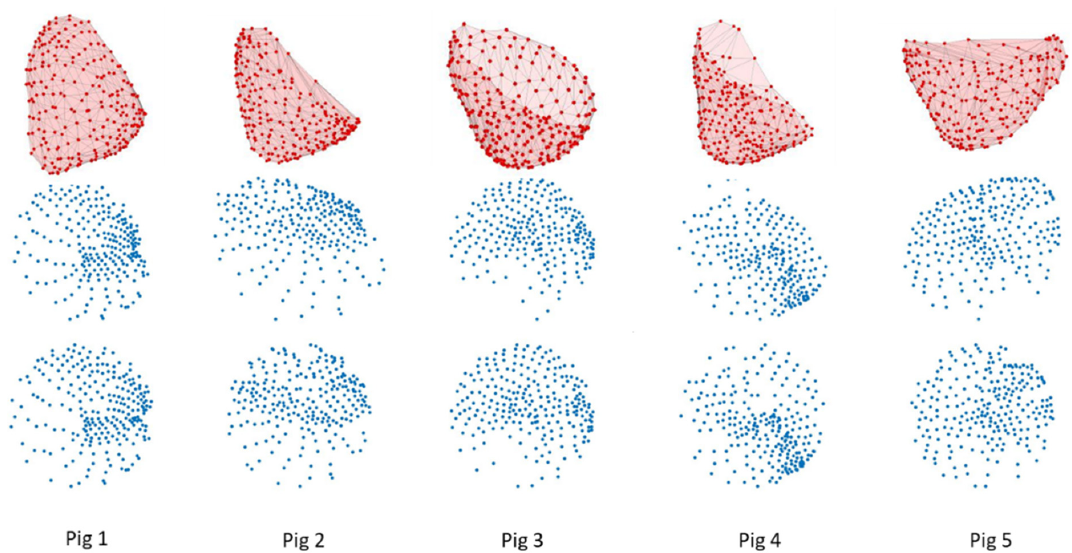
Figure 7. Results of epicardial node registration to the 2D plane. ( Top ): Original 3D distribution of the epicardial nodes. ( Middle ): Initial registration of the nodes. ( Bottom ): Further transformation of the nodes into a circular area.